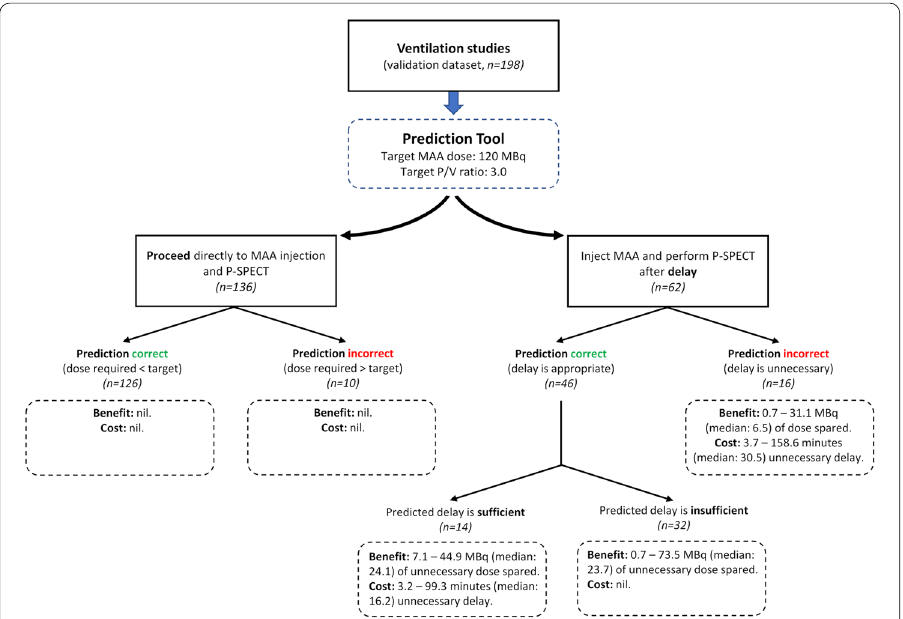
Fig. 4 Results of applying the prediction tool to ventilation studies in the validation dataset using